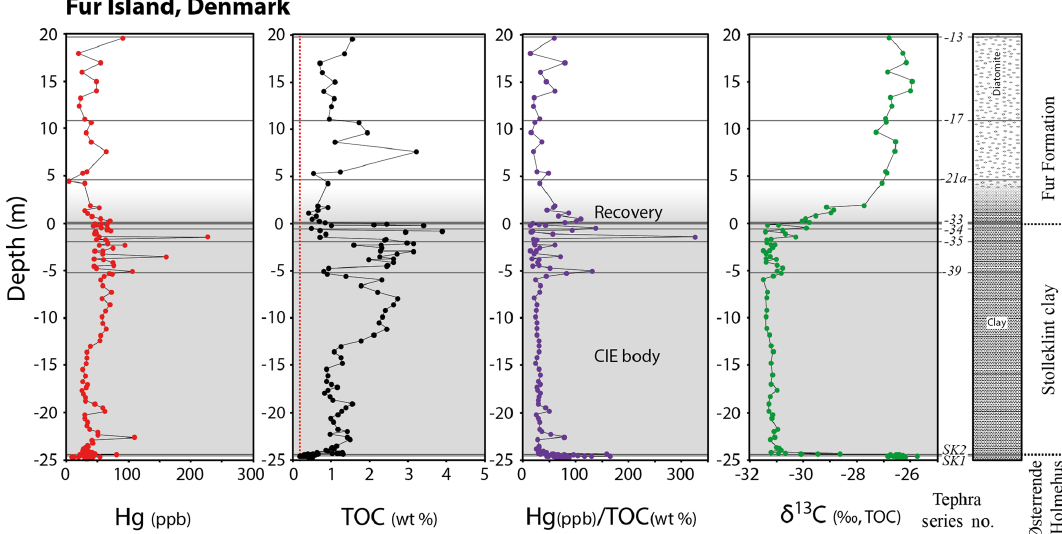
Figure 5. Mercury, TOC, Hg / TOC, and δ 13 C TOC data for the outcrops on Fur Island, Denmark. The colouring system is the same as in Fig. 3. The depth estimates are calibrated using the tephra layers no. − 34 and no. − 33, with the top of tephra layer no. − 33 set to zero. See the Supplement for full details. Only the body and recovery phases of the CIE are marked due to the condensed nature of the onset phase (see Fig. 6 for an expanded section). The stratigraphic log is based on the beach and cliff sections at Stolleklint. Boundaries between local formations are shown on the right (Heilmann-Clausen et al., 1985). Prominent tephra layers from the numbered ash series are marked with their corresponding number (Bøggild, 1918), along with the tephra layers SK1 and SK2 at the base of the Stolleklint Clay. The red dashed line in the TOC graph denotes the recommended threshold for TOC concentrations to report Hg / TOC values (Grasby et al., 2016).